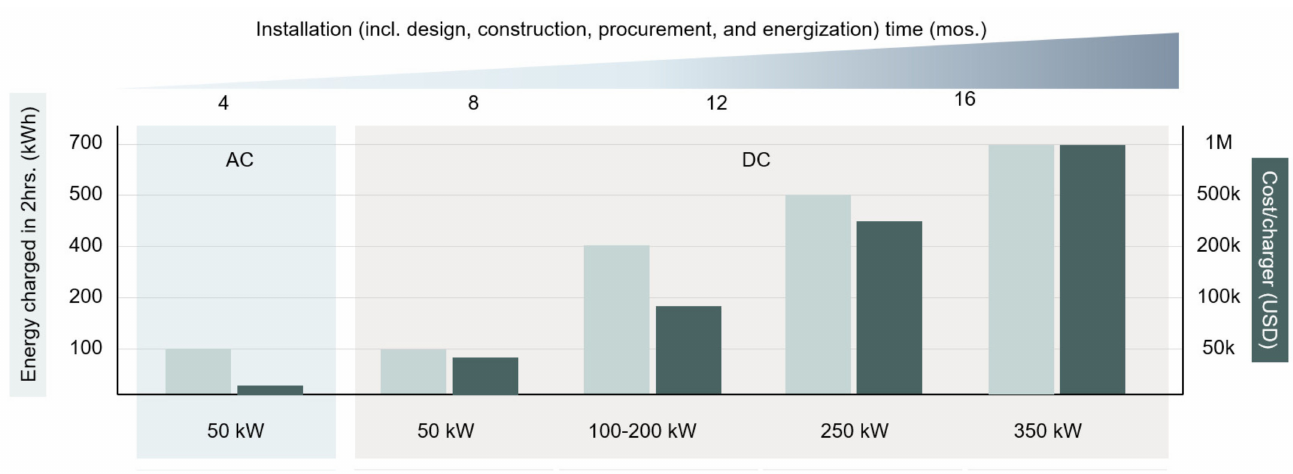
Figure 6. DC fast charging offers more power but is more expensive and time consuming to install and operate.